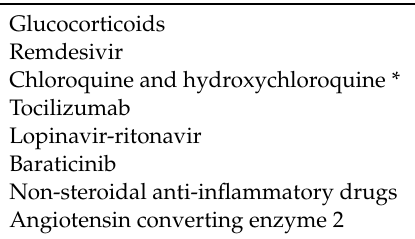
Table 2. Main Corona Virus Disease 2019 (COVID-19) pharmacological experimental